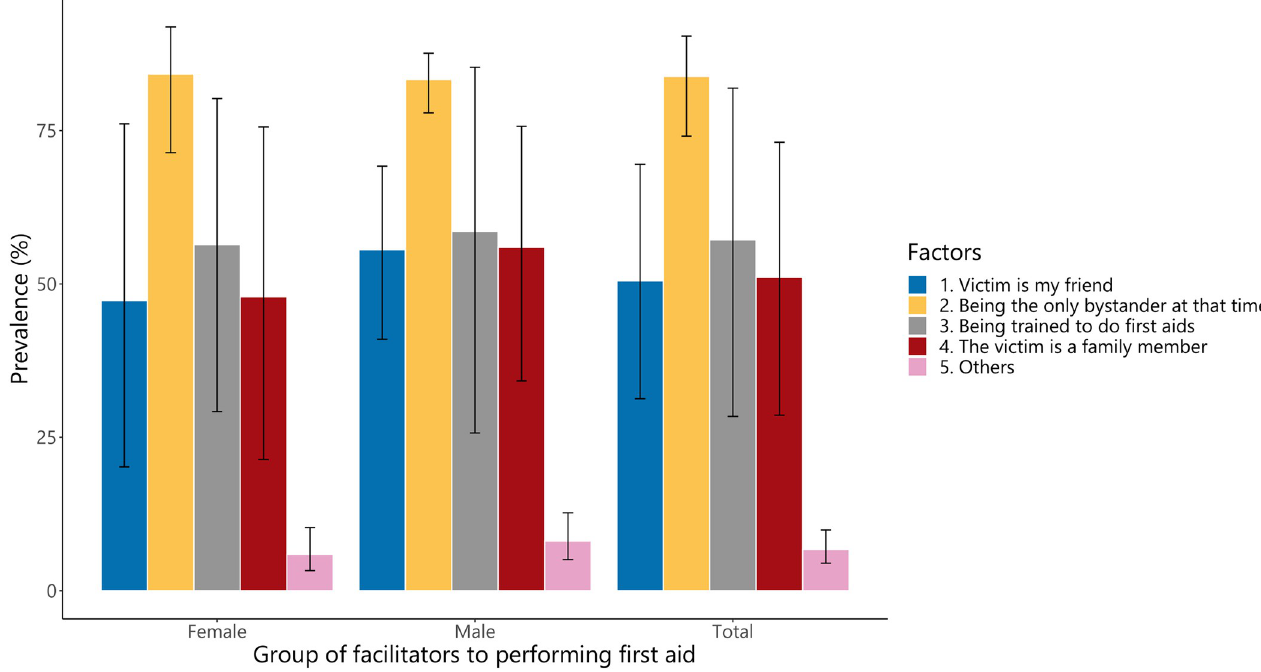
Fig 4. The facilitating factors associated with the student’s willingness to perform first aid.